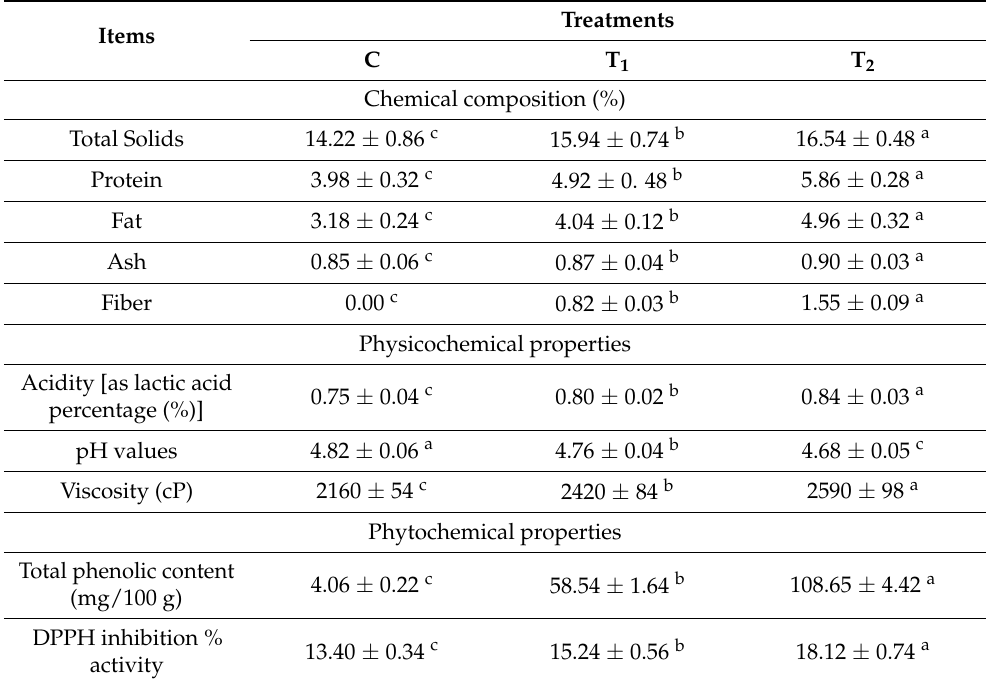
Table 2. Chemical, physicochemical, and phytochemical properties of fermented camel milk contain- ing pumpkin seed milk.